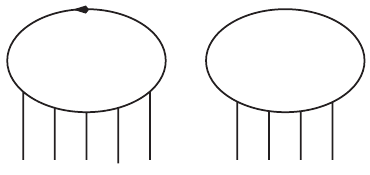
Figure 9.1 . A wheel with and without a dot.